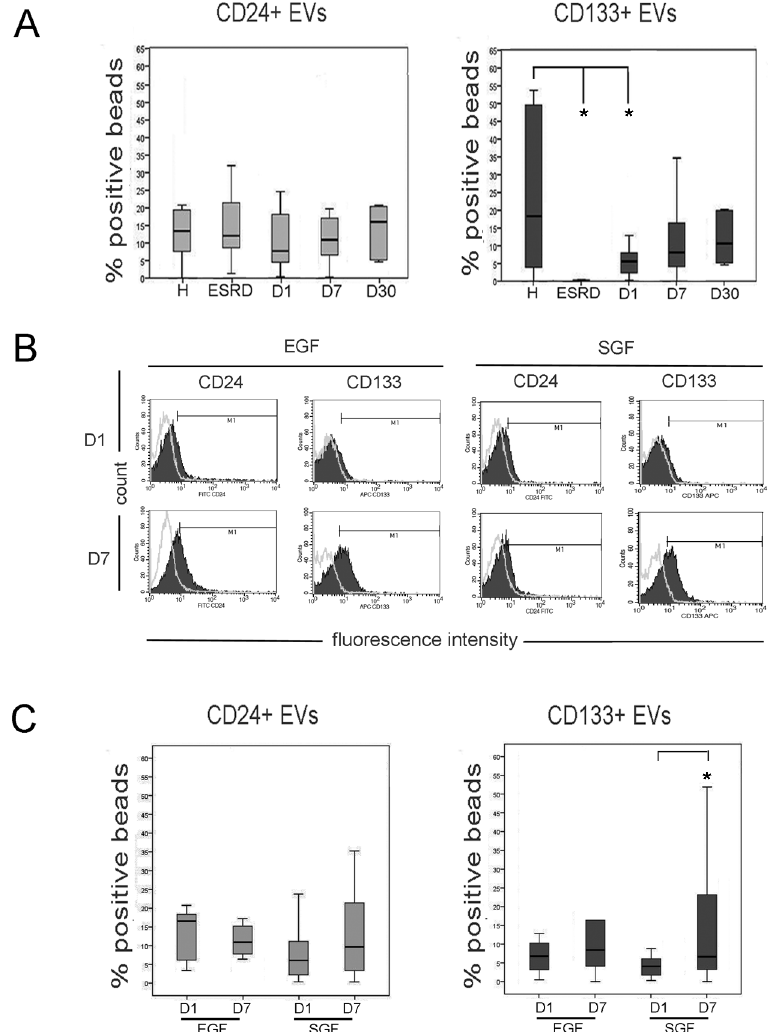
Figure 4. CD24 + and CD133 + EVs in the urine of normal subjects, ESRD and transplanted patients. Panel A. Levels of urinary CD24 + and CD133 + EVs in normal subjects (H), ESRD patients with residual diuresis and transplanted patients at day 1, 7 or 30 after transplant (D1, D7 and D30, respectively). A significant reduction of CD133 + EVs but not of CD24 + EVs was observed in ESRD and transplanted patients at day 1. Data are expressed as % positive beads and are mean 6 SD of all samples. Panel B and C . Representative cytofluorimetric histograms (B) and median values (C) of CD24 + and CD133 + EV levels in the urine of patients with EGF (n=13) and SGF (n=12) at day 1 and 7 after transplant. Urinary CD133 + EVs but not CD24 + EVs were lower in EGF patients at day 1, and significantly increased at day 7. Statistical analysis was performed as described in the Materials and methods section. *=p , 0.05.